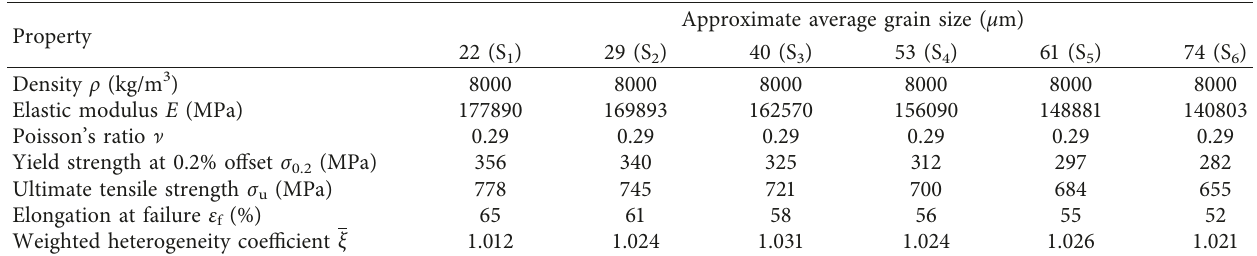
Figure 1: Schematic diagram of the constitutive model with consideration of grained inhomogeneity. Table 1: Average values of properties of 304 stainless steel specimens with different average grain sizes.